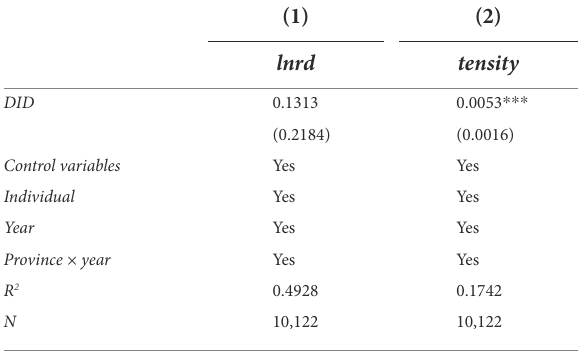
TABLE 7 Innovation input mechanism